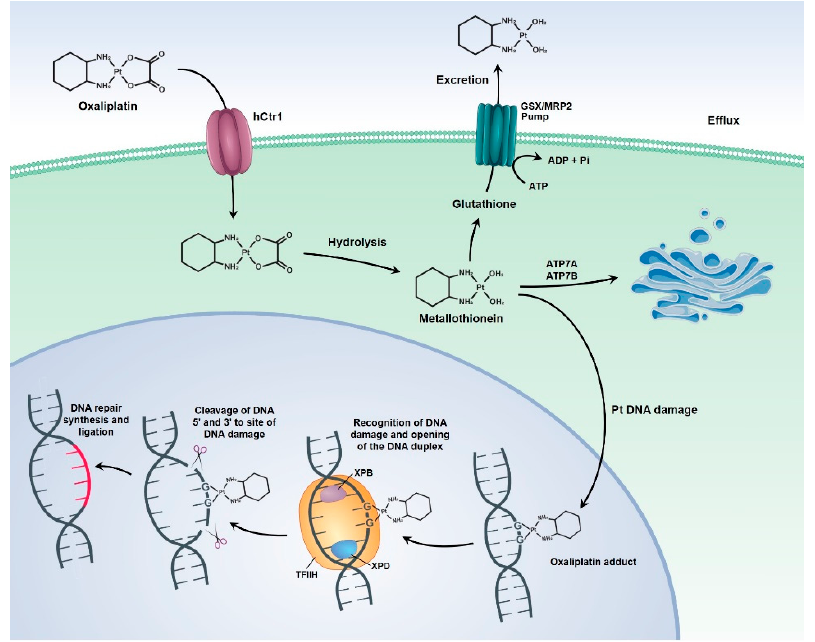
Figure 3. Tumor cell resistance mechanisms to OXA. The image shows the mechanisms of DNA repair and drug